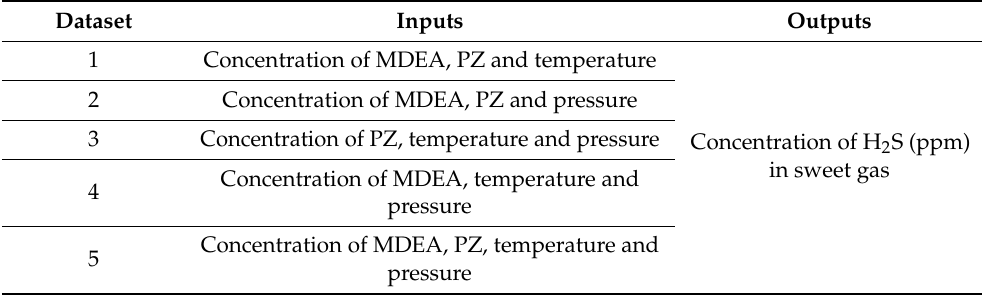
Table 5. Combination of input parameters in determining the concentration of H 2 S in sweet gas. Dataset Inputs Outputs 1 Concentration of MDEA, PZ and temperature gas2 Concentration of MDEA, PZ and pressure 3 Concentration of PZ, temperature and pressure Concentration of H 2 S (ppm) in sweet Concentration of MDEA, temperature and 4 pressure Concentration of MDEA, PZ, temperature and 5